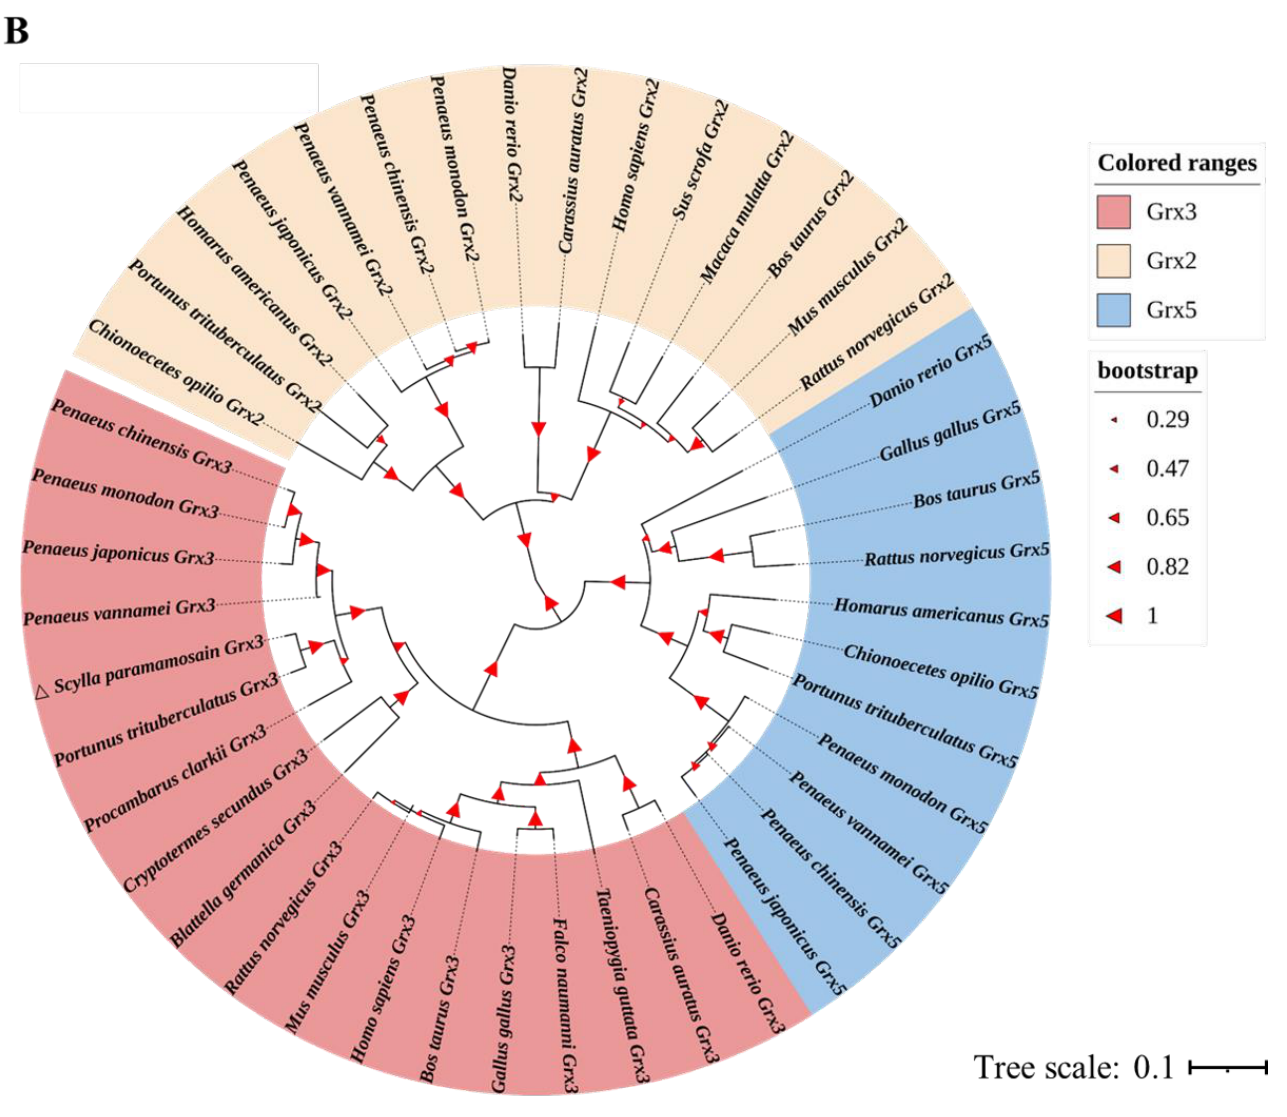
Figure 3. ( A ) Multiple sequence alignment of Grx3 from other species. Red regions indicate conserved amino acid residues. Red letters indicate similar residues. The conserved active sites, C-G-F-S, are shown in the black boxes. The results of the amino acid sequence counts are shown at the top of each row. ( B ) A neighbor-joining phylogram of SpGrx3 with Grxs sequences from other species. SpGrx3 is indicated by a triangle.